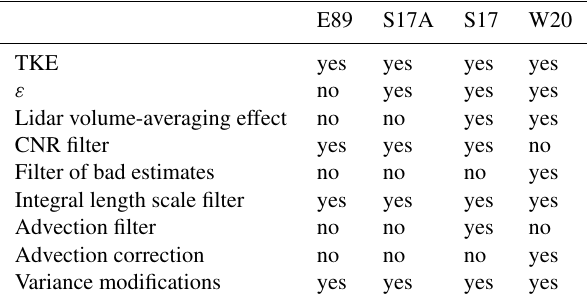
Table 2. Overview of turbulence retrieval methods and the applied filters and